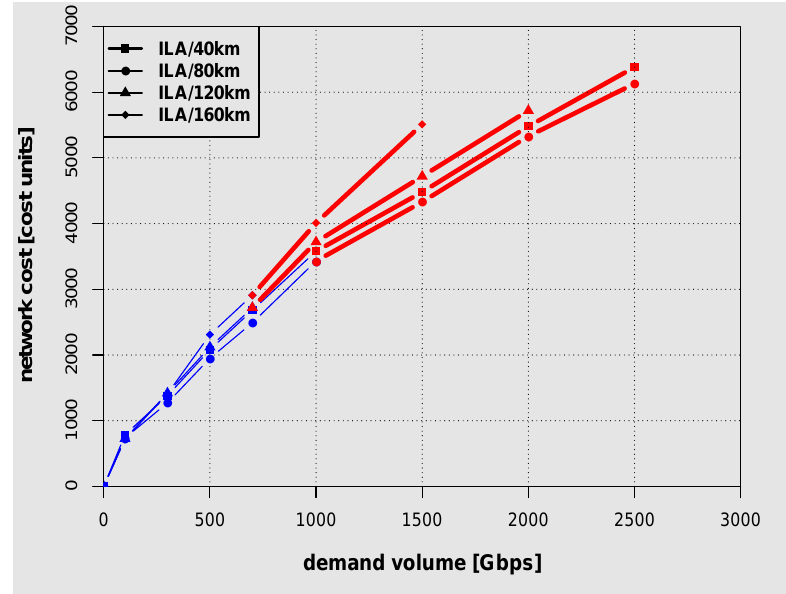
Figure 9. The dependence of network cost on the demand volume for German